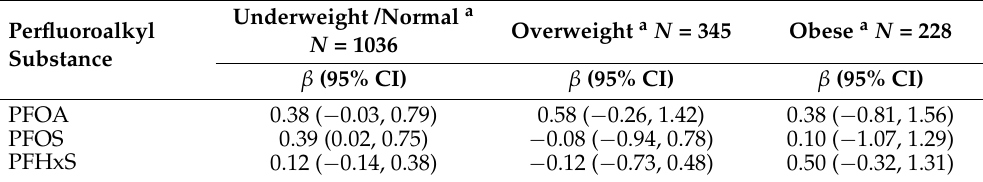
Table 3. Multivariate linear regression of first trimester log 2 perfluoroalkyl substance concentrations (ng/mL) and total GWG (parameter coefficients, 95% CI) stratified by pre-pregnancy BMI.